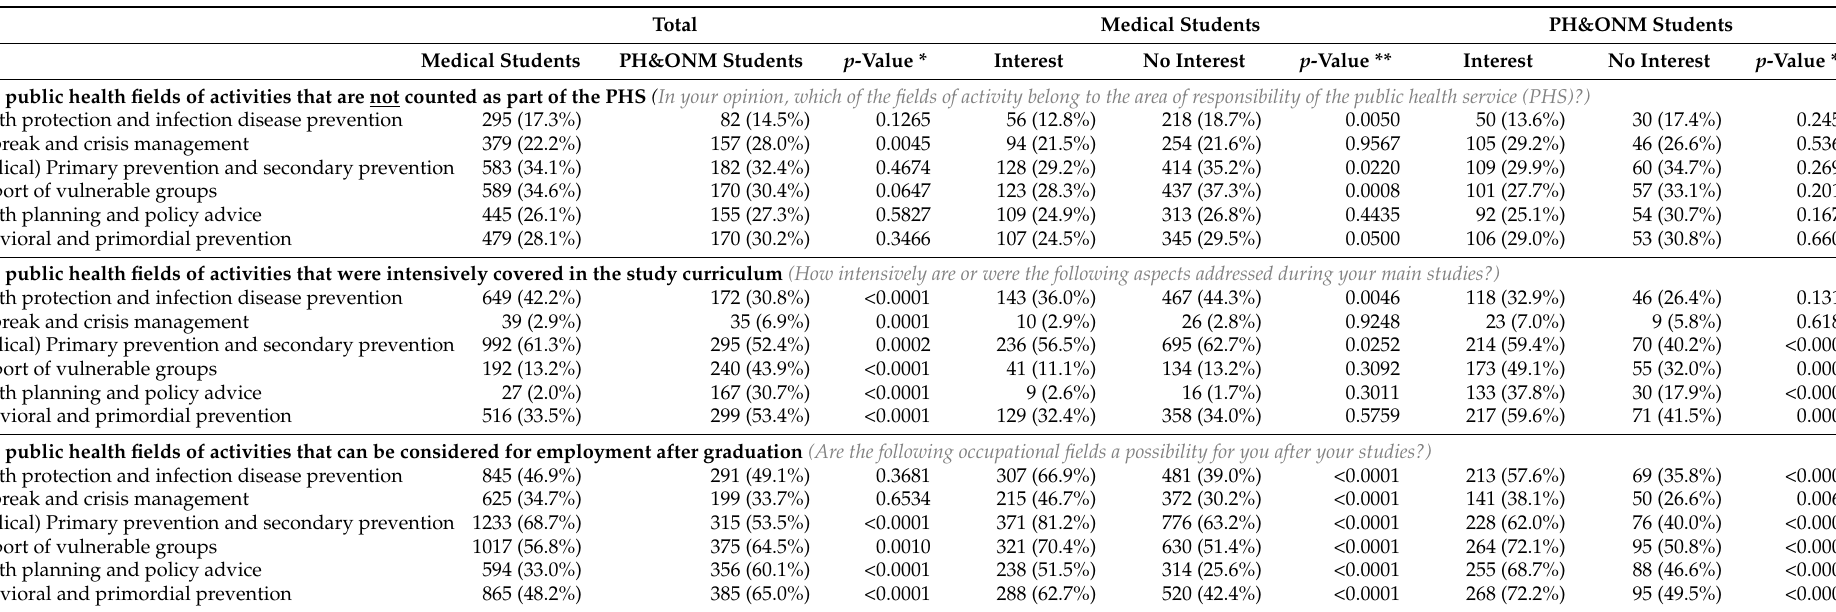
Table 3. Specific knowledge about and interest in topics, tasks and activities of the PHS in Germany: Absolute and relative proportion of core public health fields of activities regarding their PHS attribution, coverage within the study curricula, and consideration of prospective employment by field of study and PHS interest in wave 1,